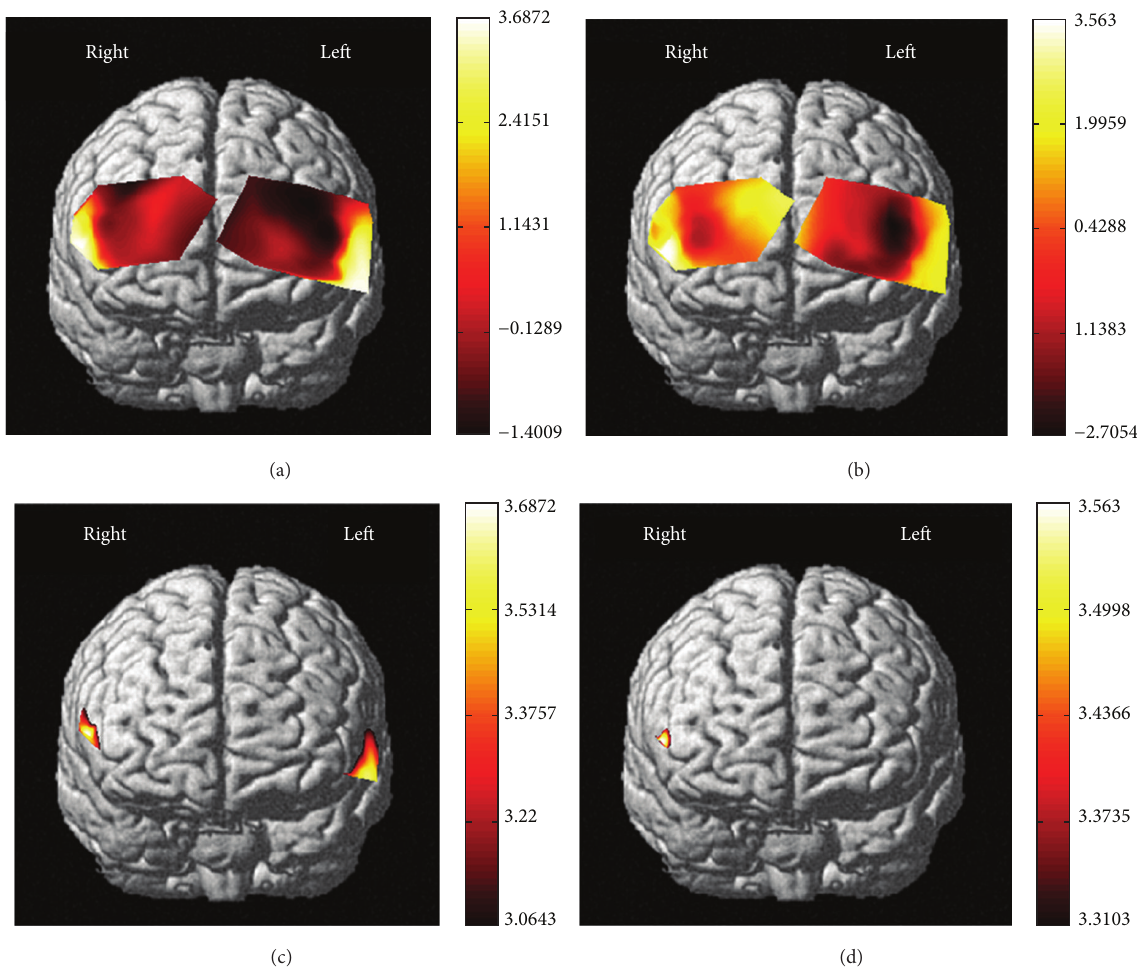
Figure 4: Individual maps. Individual 𝑡 -statistic maps from (a) HbO and (b) HbR. Individual activation maps from (c) HbO and (d)